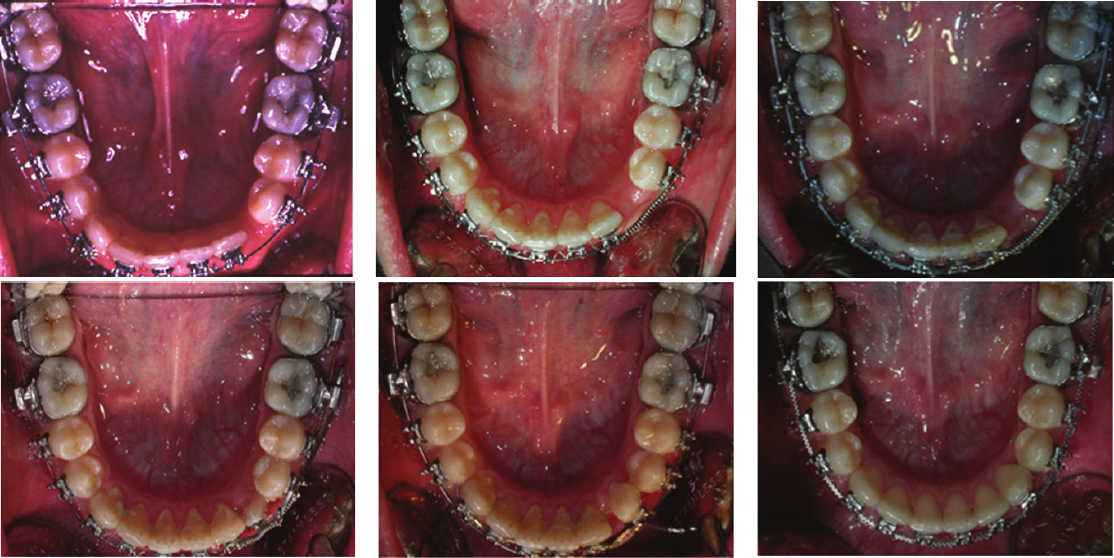
Figure 7: From left to right, progressive recovery of the mandibular